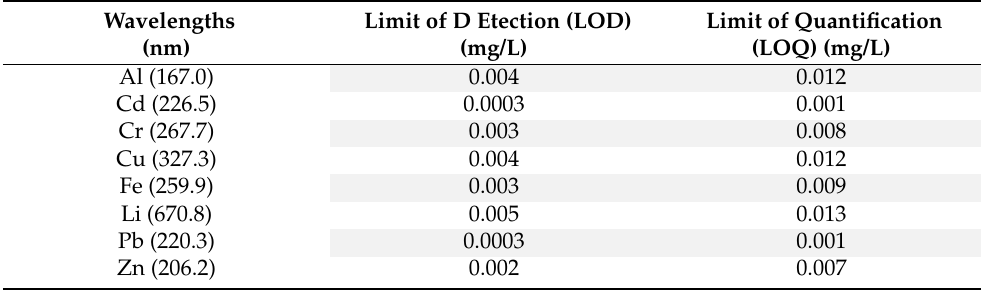
Table 1. Limits of detection and quantification of each metal measured by